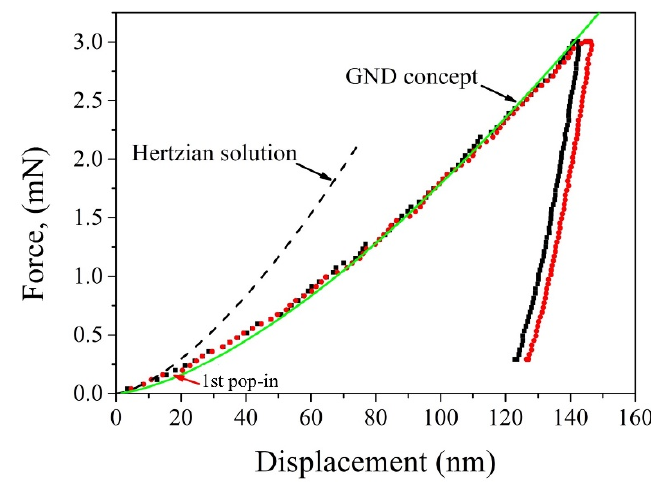
Figure 2. The P - h curve of individual austenite grain in a medium Mn steel with a dual-phase microstructure of austenite and martensite (Fe-0.45C-10Mn-1Al in wt.%). The dashed line is the Hertzian solution. The solid line is the fitting curve using the GND concept.